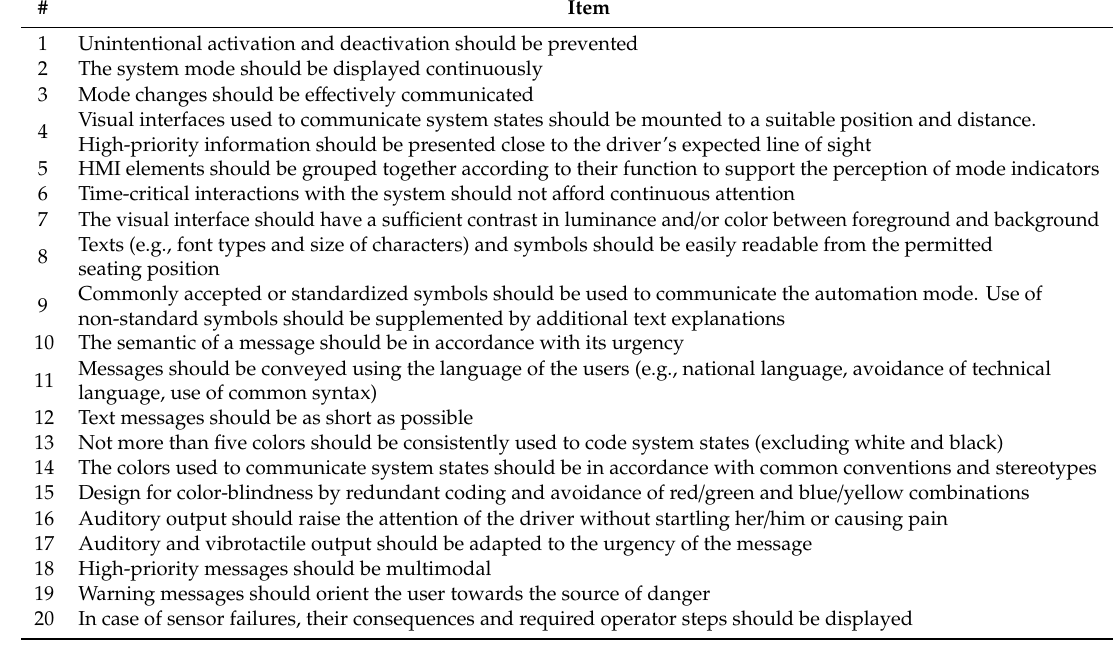
Table 1. List of heuristics (see also [5]). HMI, human–machine